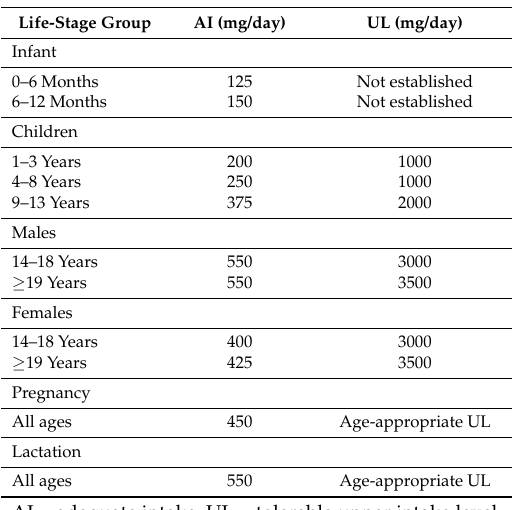
Table 1. Dietary reference intakes for